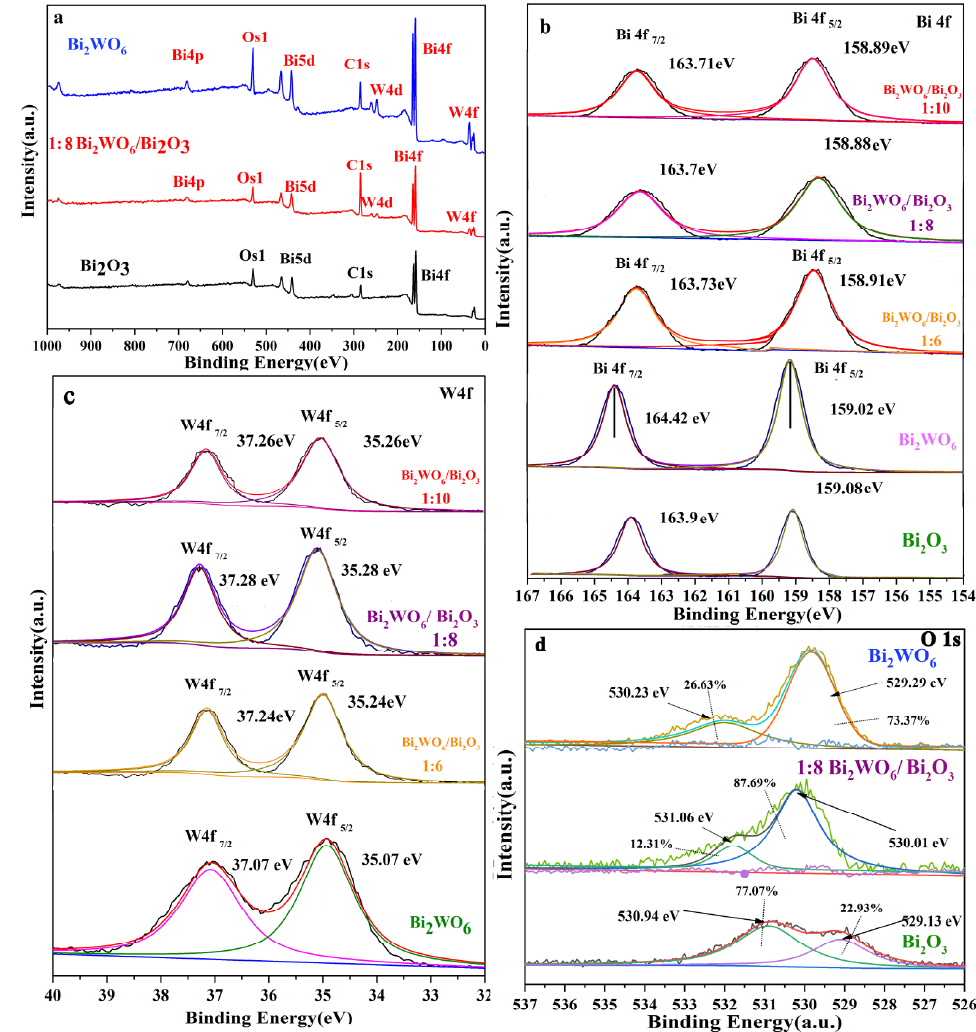
Figure 4. XPS spectra of Bi 2 WO 6 , 1:8 Bi 2 WO 6 /Bi 2 O 3 , and Bi 2 O 3 ( a ); survey spectra for Bi 4 f ( b ); W4f spectrum ( c ); O1 s spectrum ( d ).